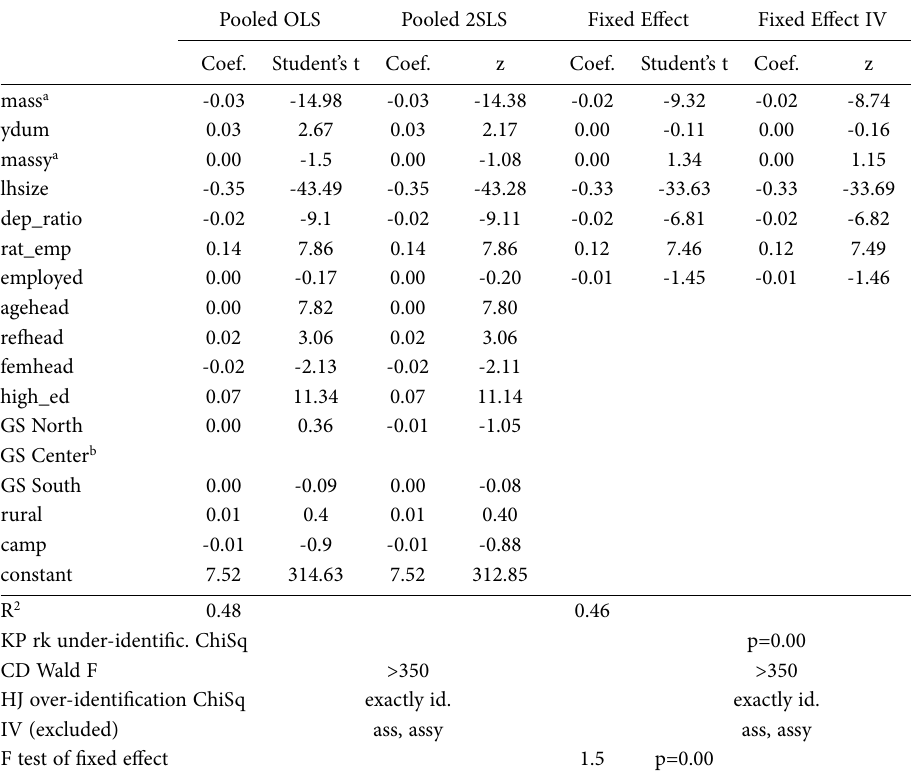
Table 11. Asset-based poverty index regression models, Gaza